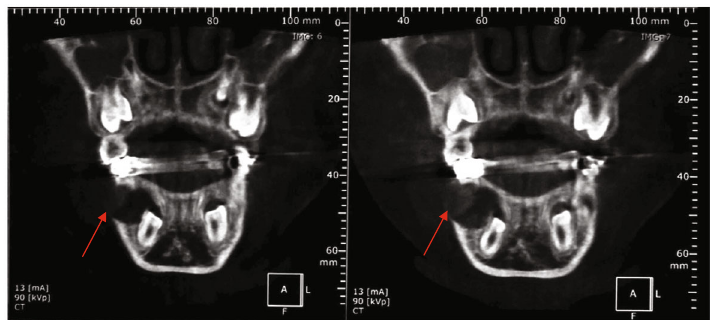
Figure 4: Sagittal sections showing a 12 mm diameter well-de fi ned radiolucent lesion surrounding the crown of the unerupted fi rst premolar (# 44) (red arrow).